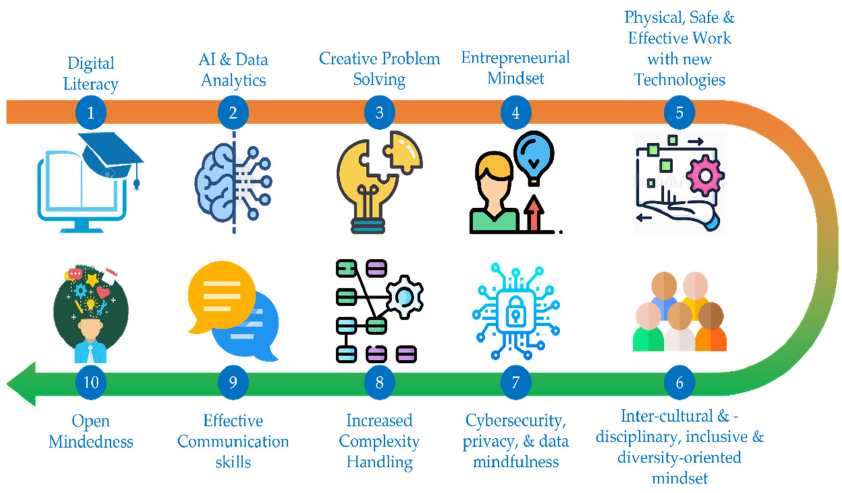
Figure 13. Ten Critical Skills facilitating the realization of Society 5.0, derived from